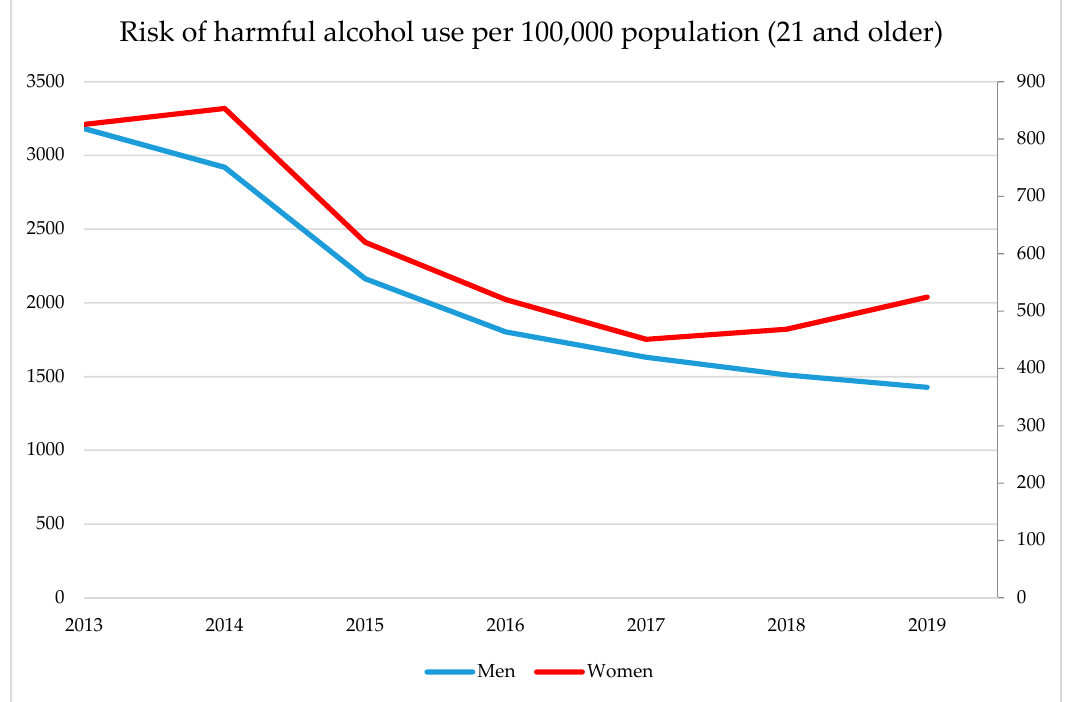
Figure 6. Age-standardized rate of harmful alcohol consumption per 100,000 population (aged 21 and older), defined as a score of ≥ 2 according to the CAGE screening tool (until 2018) and as ≥ 3 for women and ≥ 4 for men for AUDIT-C (starting from 2018). Left scale: men, right scale: women. Source: National Medical Research Center for Therapy and Preventive Medicine of the Ministry of Health of the Russian Federation.